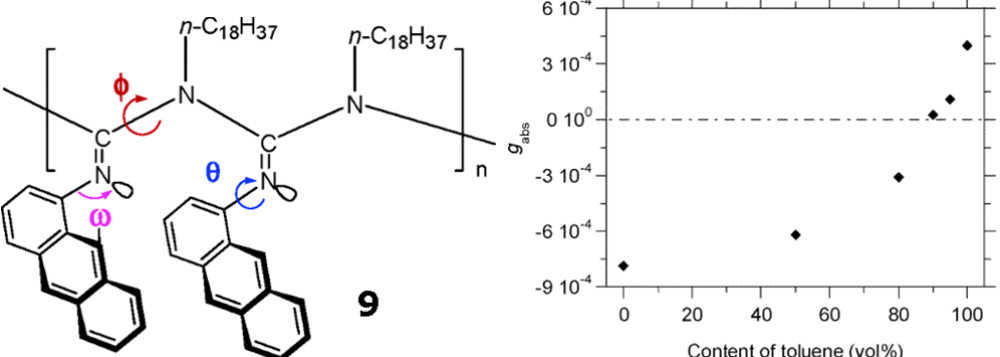
Figure 14. Kuhn’s dissymmetry ratio, g (=  ), at 380 nm of 9 in toluene/THF at 25 °C abs clearly demonstrates the chiroptical inversion driven by the change in solvent composition between toluene and THF. The chiroptical inversion occurs around 90% content of toluene [70]. Reproduced by permission of the American Chemical Society.